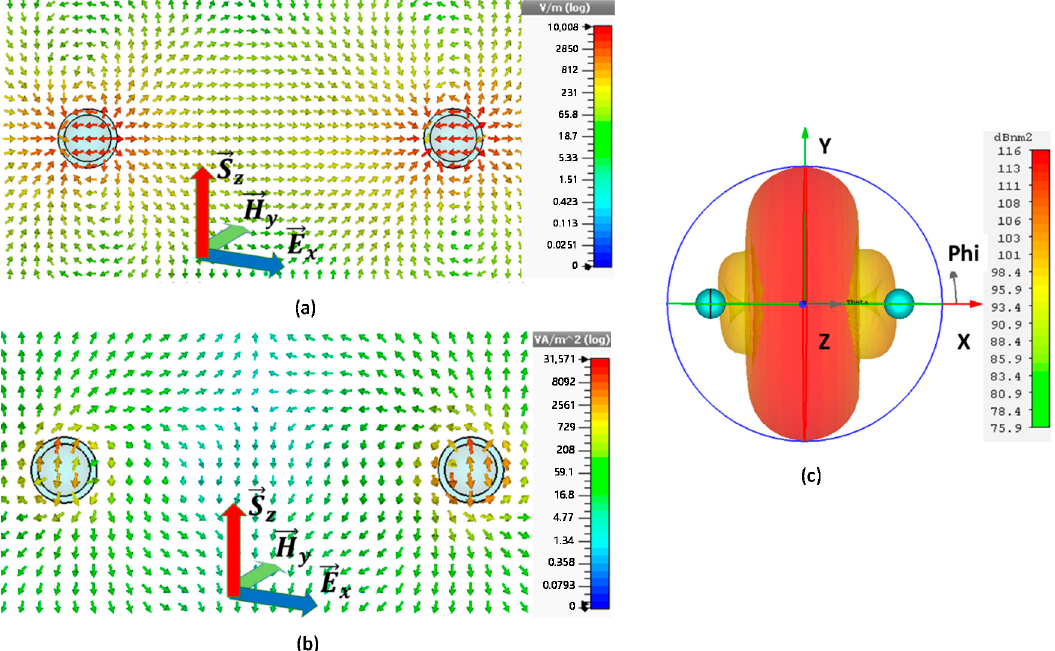
Figure 3. Field distribution of A-CNPs configuration I with maximum SCS peak at f = 600.0195 THz: ( a ) electric field distribution, ( b ) power flow in xoz plane. ( c ) far-field pattern.